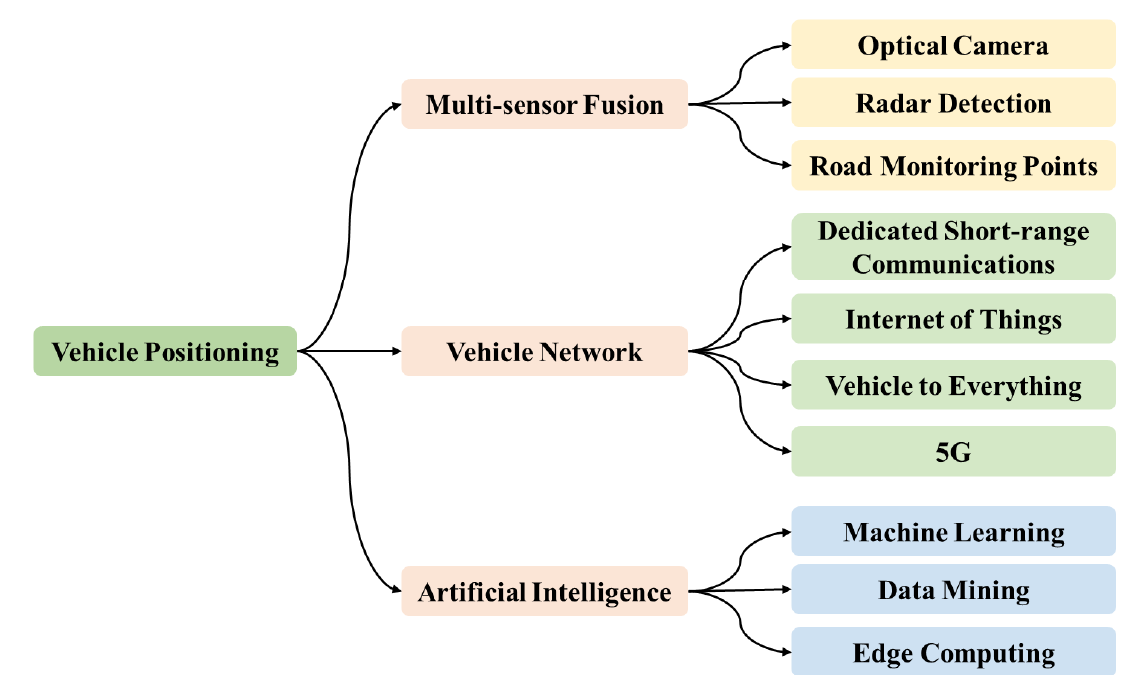
Figure 1. Different methods of vehicle positioning.